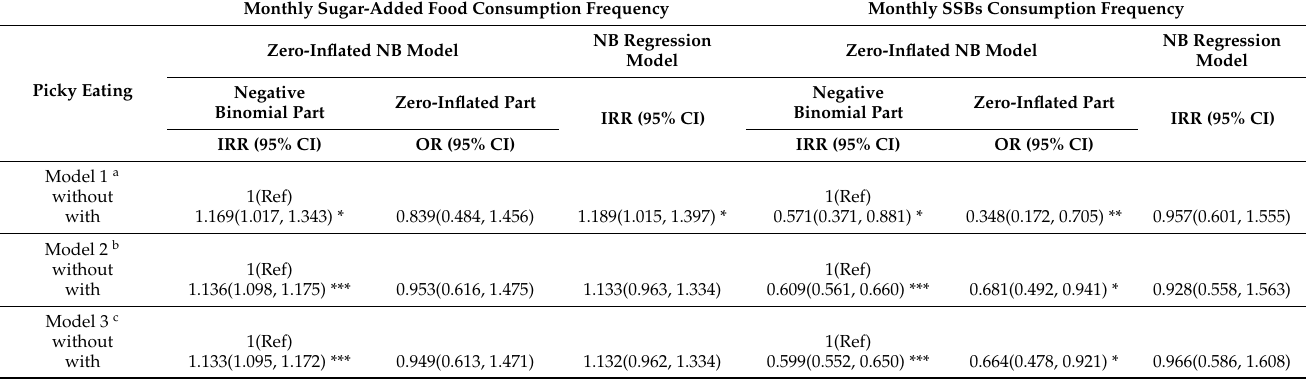
Table 3. Associations between picky eating and the consumption frequency of products with added